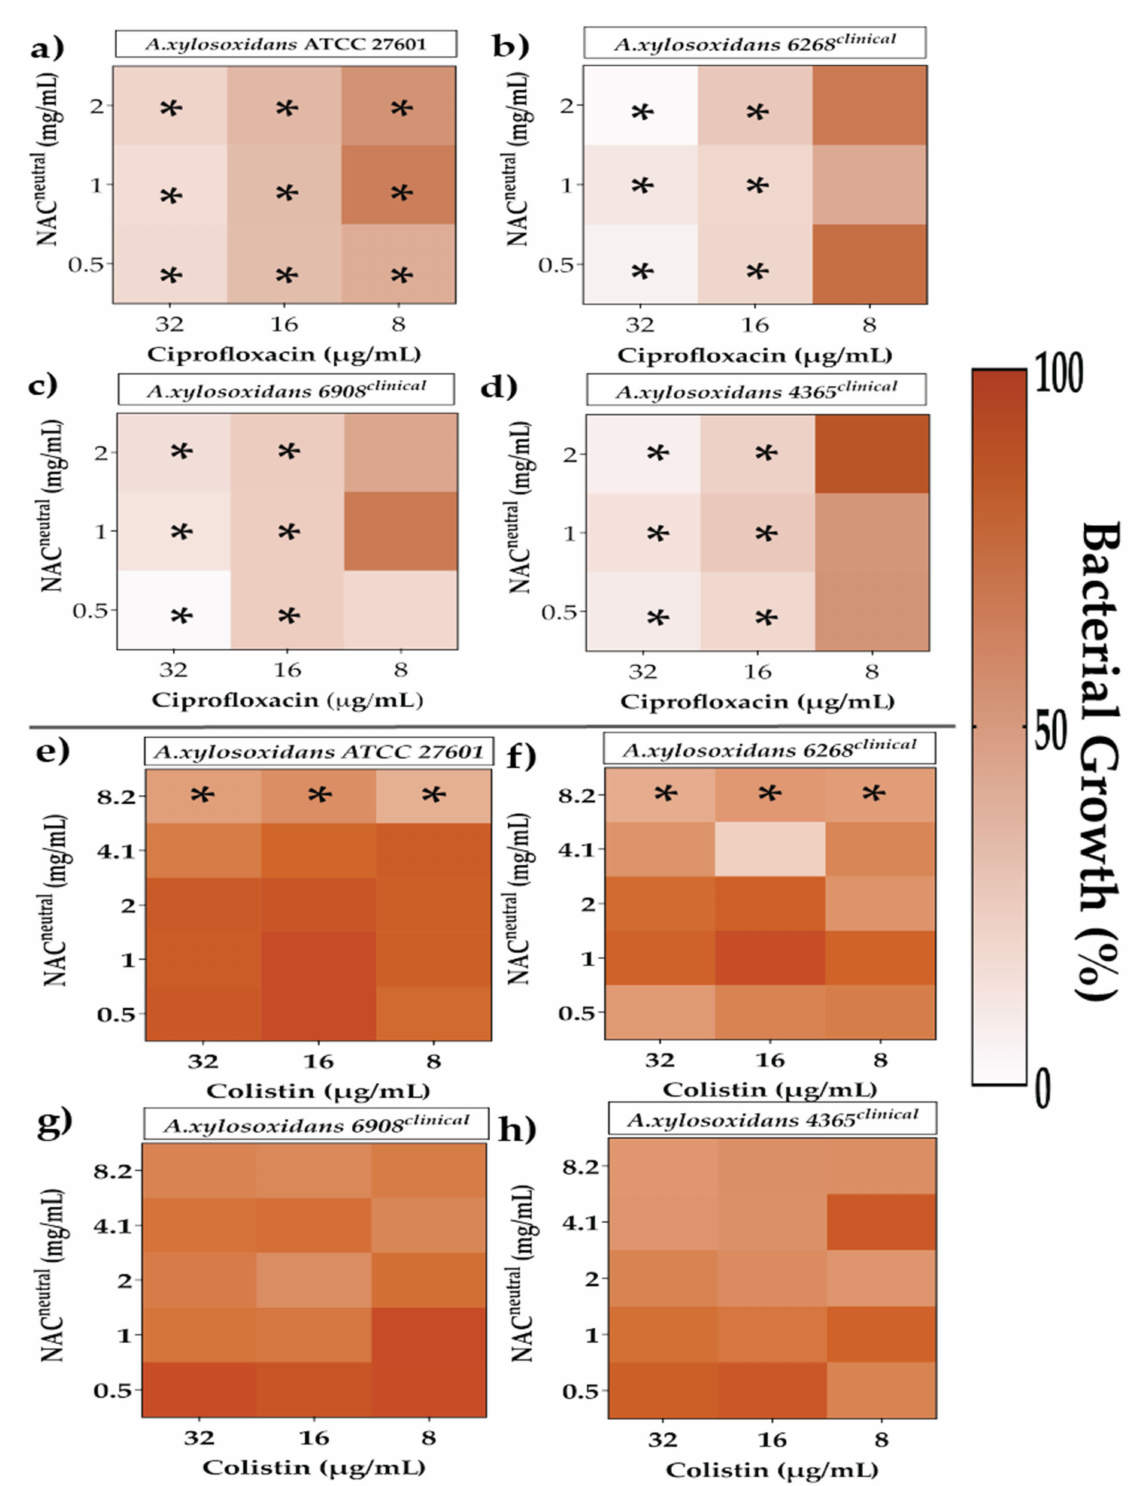
Figure 4. The effect of chosen synergistic and additive combinations against irreversibly attached Achromobacter xylosoxidans . Heat map representing greyscale-coded planktonic bacterial growth where black represents 100% bacterial growth and white represents 0% irreversibly attached planktonic bacterial growth. Irreversibly attached bacterial growth has been measured in the presence of ciprofloxacin ( a – d ) and colistin ( e – h ) in combination with NAC neutral for A. xylosoxidans strains. Statistical analyses were performed using one sample t -test and Wilcoxon rank tests. Significance cut-offs are as follows p ≤ 0.05 ( * ). Data represent an average of n = 3 biological